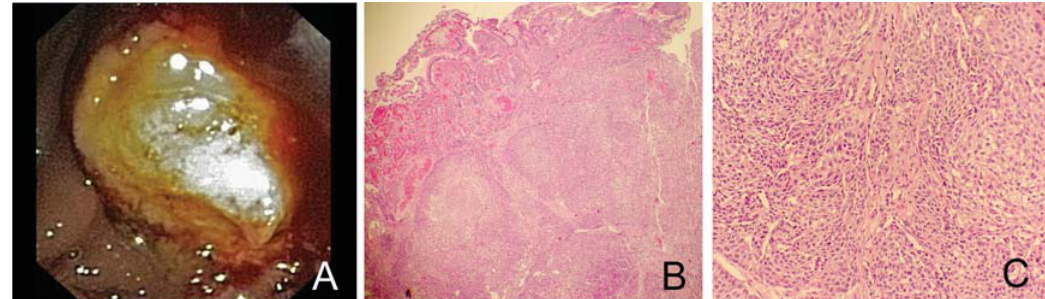
FIGURE 1. Polypoid tumor with ulcerated surface at the Ampulla of Vater (A). Histopathologic examination revealed a highly cellular tumor nests and islands composed of heterogenous population of malignant cells diffusely infi ltrating mucosa and sub- mucosa of the ampullar region (B,